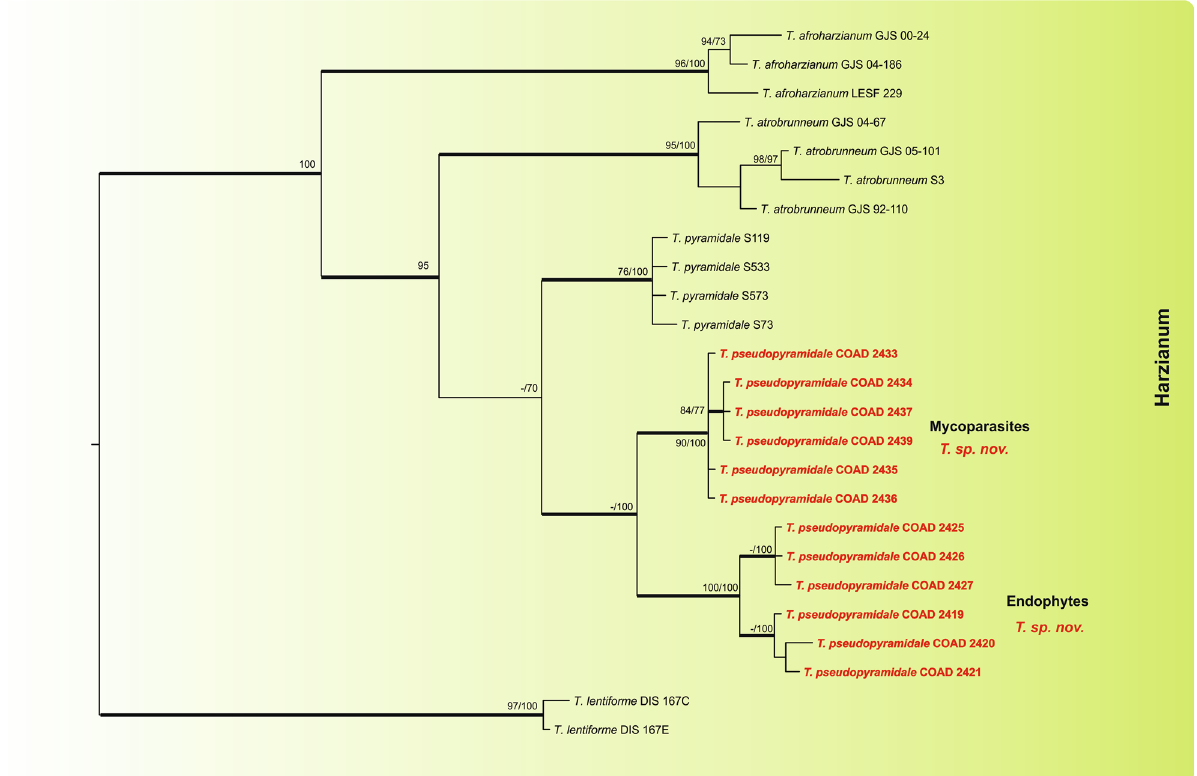
Figure 3. Bayesian phylogenetic tree of T. pyramidale and T. pseudopyramidale sp. nov. The tree was based on a concatenated tef1, rpb2 and cal sequence dataset. Bootstrap values (≥ 70%) of the ML and MP analyses, as well as posterior probability scores (≥ 0.9) from a Bayesian analysis of the same dataset, are indicated at well supported nodes together with thickened branches. The isolates belonging to known species, obtained in this study, are in bold. Isolates of new species, described in this study, are in bold red. The tree was rooted with Trichoderma lentiforme (DIS 167C and DIS 167E). The phylogenetic tree was edited using Inkscape 1.0 (https :// inksc